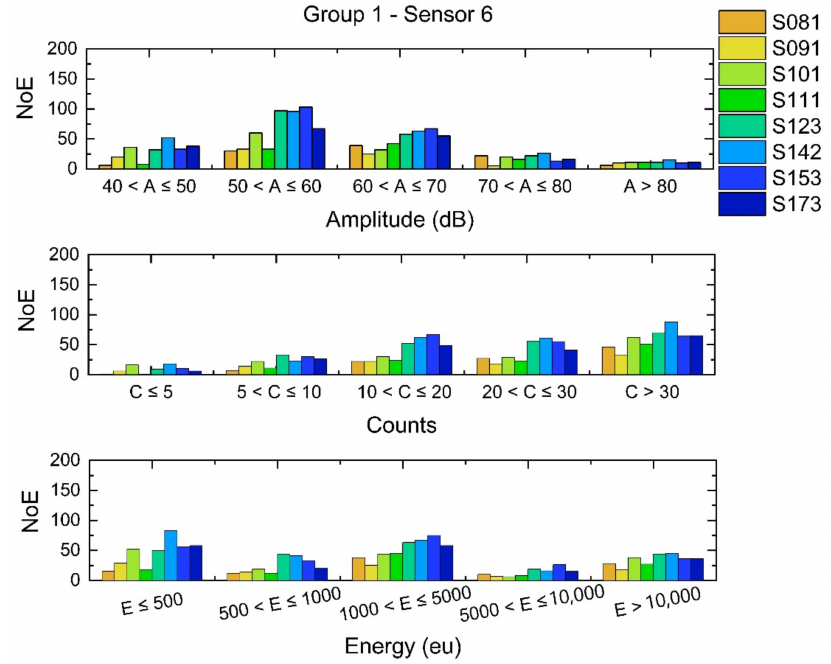
Figure 5. Number of events (NoE) registered during brittle fracture for Group 1 recorded by sensor 6. Each sample is identified by an ID number “Sxxy” corresponding to the number of slice (xx) and the count of the produced sample in the slice (y). ( Top ) amplitude; ( Middle ) counts; ( Bottom ) energy released by the